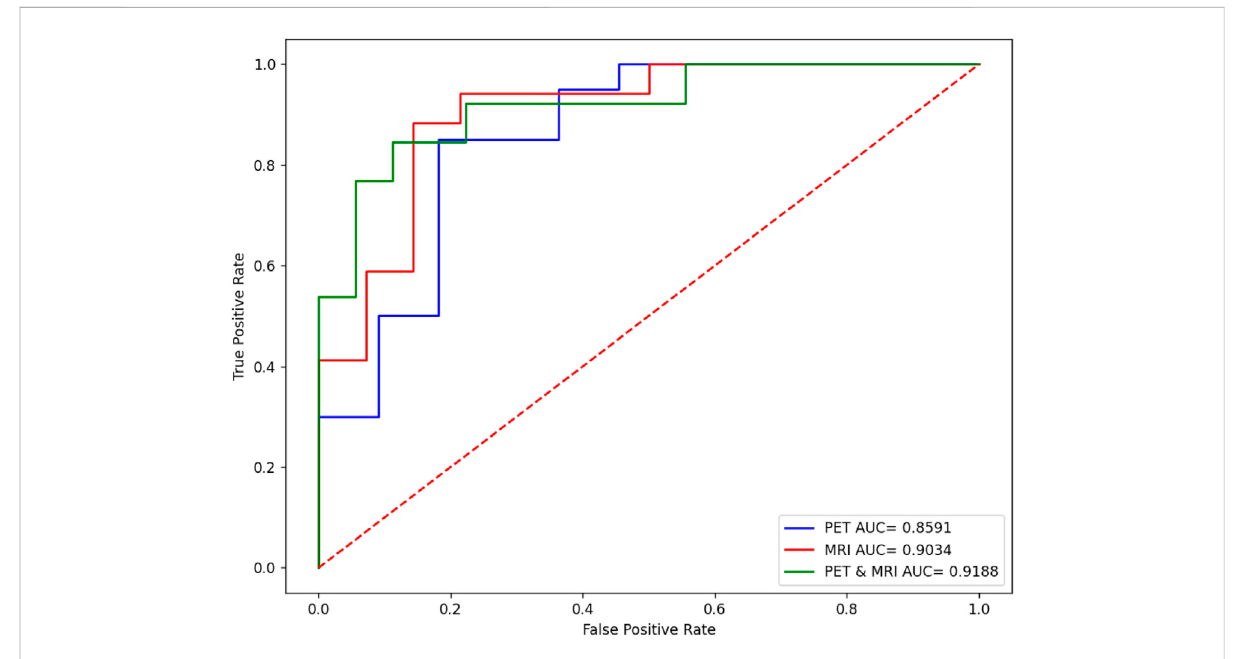
FIGURE 6 Performance comparison of sMRI, PET, and their